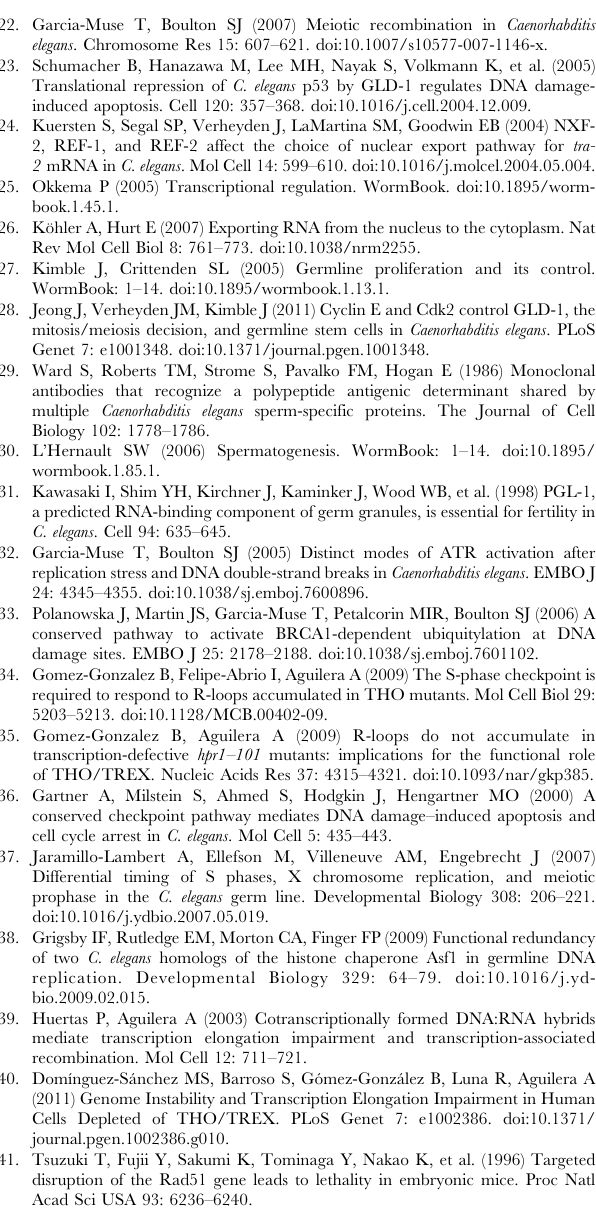
matogenesis marker. ( D ) RT-qPCR quantification of the indicated genes involved in subsequent steps of spermatogenesis in N2(wt) and thoc-2 mutant worms. Figure S3 Response to replication stress in thoc-2 . Representative images of a single focal plane through the mitotic region of the germline from animals of the indicated genotype counterstained with DAPI and quantification of the number of mitotic nuclei and the mitotic region length. Error bars indicate standard errors of means (n= 30). Statistically significant differ- ences versus the untreated N2(wt) (p , 0.001) is indicated by an asterisk * (Student’s t-Test).